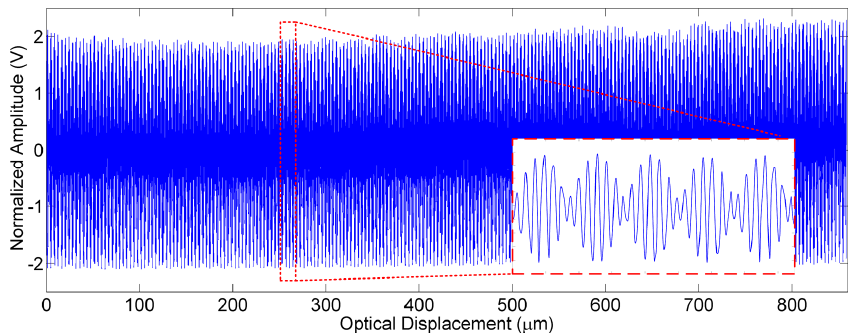
Figure 10. The resampled interferogram signal of the test light in spatial domain.